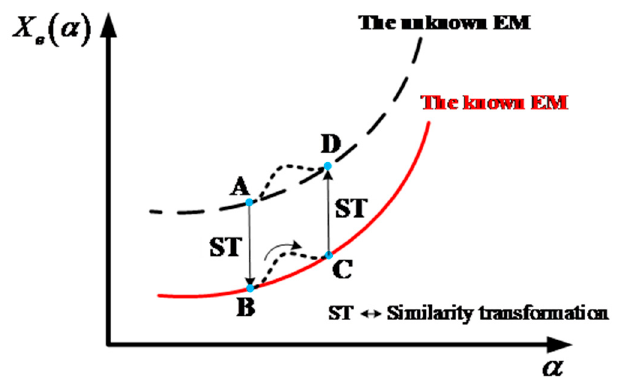
Figure 7. Computational process of CEME model.